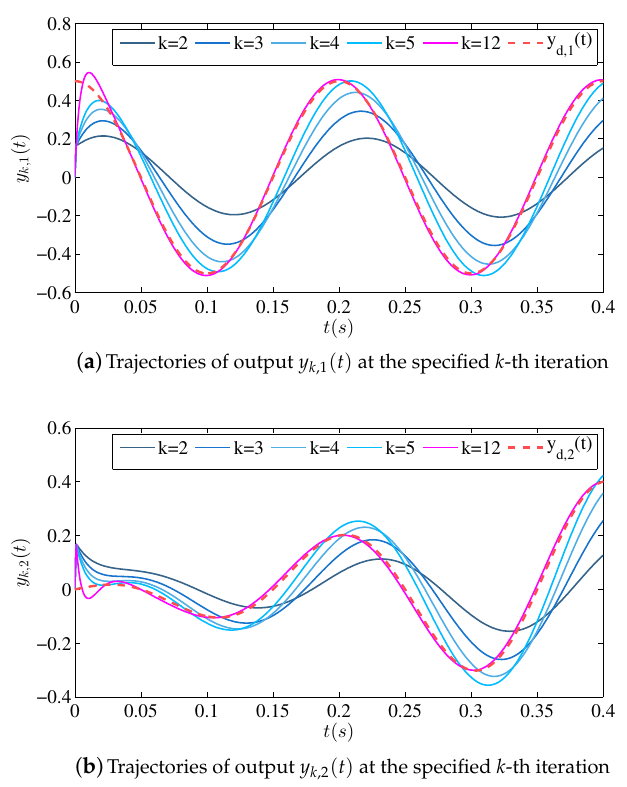
Figure 5. Trajectories of outputs y k , i ( t ) at the specified k -th iteration using closed-loop iterative learning schemes (20).